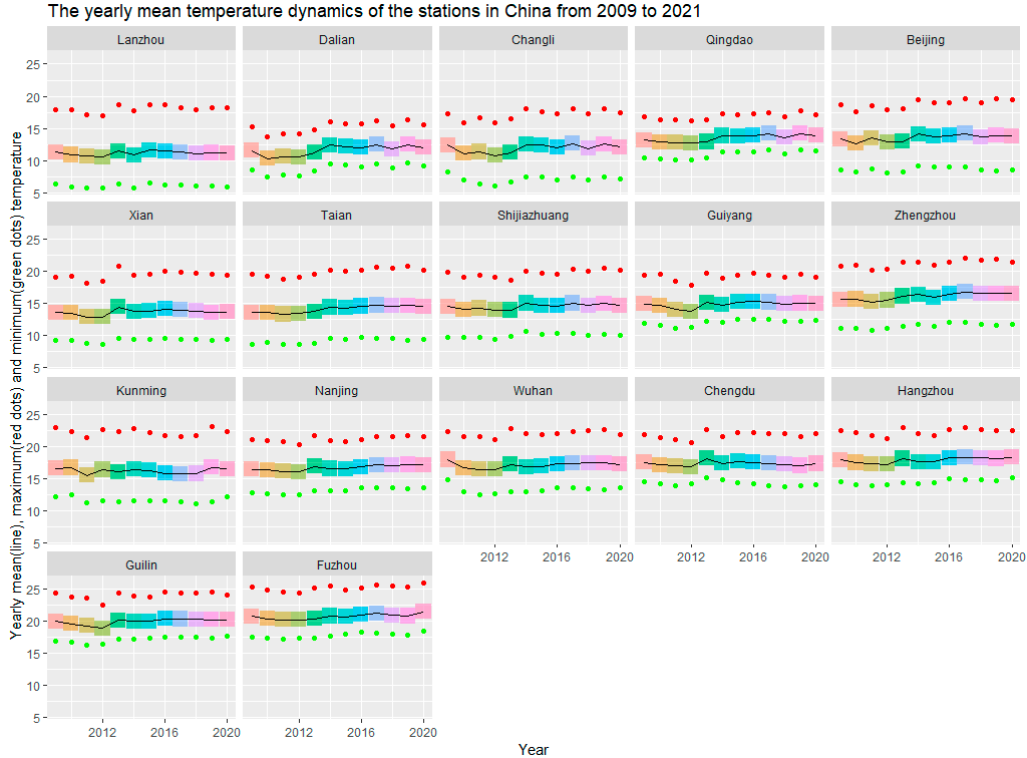
Figure 2. The yearly mean (line), maximum (red dots), and minimum (green dots) temperature dynamics of the 17 stations in